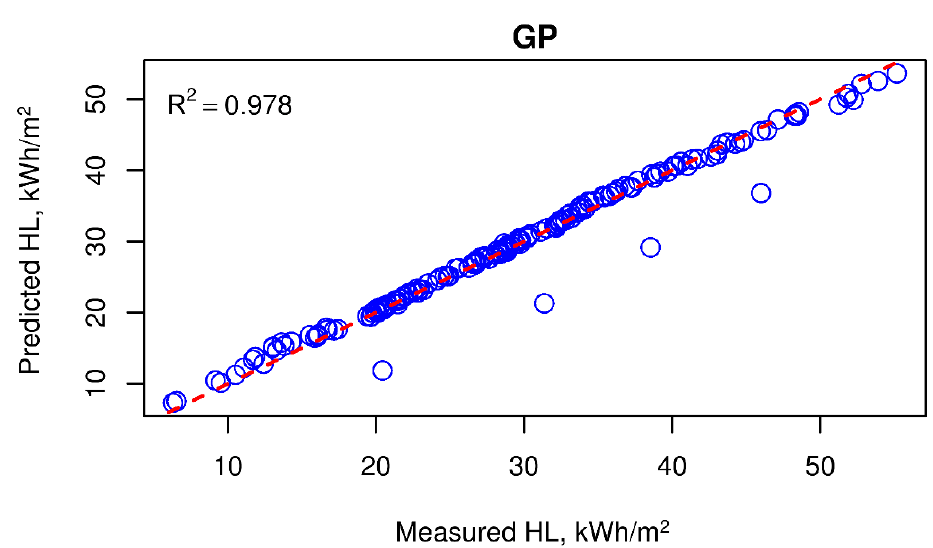
Figure 15. The results of HL prediction from the GP model.